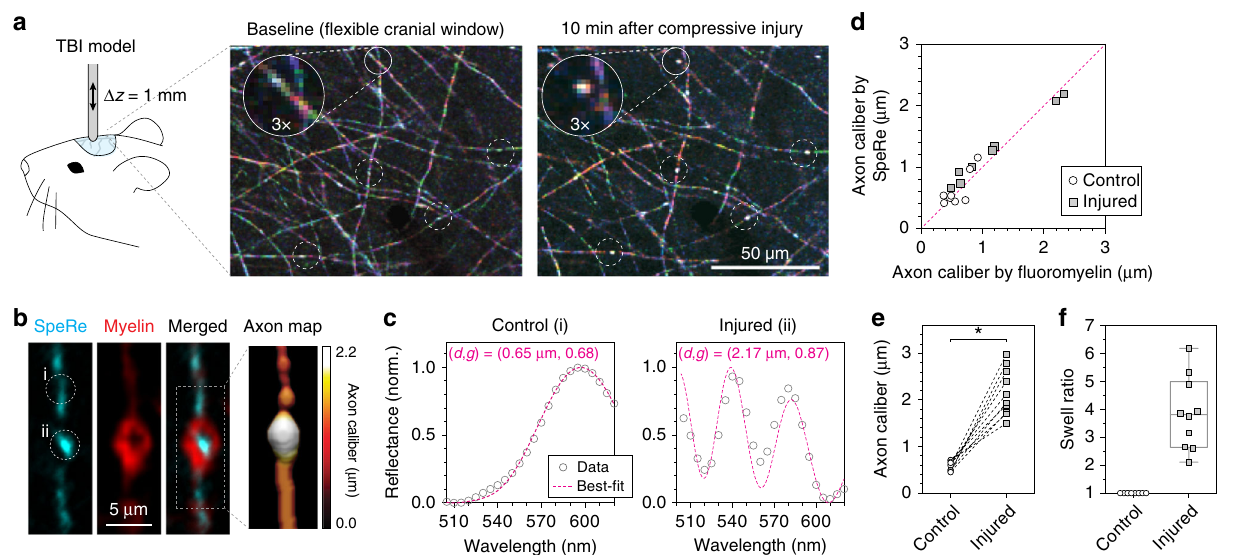
Fig. 6 In vivo imaging of nanoscale axonal pathology in traumatic brain injury. a SpeRe images of the live mouse cortex (layer I) before and after mild compressive injury (1 mm indentation for 30 s). White circles indicate injured axon segments. b An injured axon from a cortical tissue slice imaged ex vivo using re fl ectance (cyan) and fl ouromyelin fl uorescence (red). The axon map was reconstructed using the axon diameters obtained by fi tting the measured spectrum for each segment to simulation data. c Re fl ectance spectra of the nearby control and injured axon segments, which are indicated as ‘ i ’ and ‘ ii ’ , respectively, in b . Dotted lines in magenta are simulation curves that provide the best fi t to experimental spectra (caliber = 0.65 μ m, g -ratio = 0.68 for control; caliber = 2.17 μ m, g -ratio = 0.87 for injured). d Validation of axon caliber measurement by SpeRe in injured axons. Dotted line in magenta is a unity line ( R 2 = 0.94, n = 10 axons). e Quanti fi cation of axon diameter in nearby control and injured axon segments. f Swell ratio in the bulged axon quanti fi ed by dividing the axon diameter in the bulging region by the axon diameter in the nearby control segment. * p < 0.0001 (paired t -test,